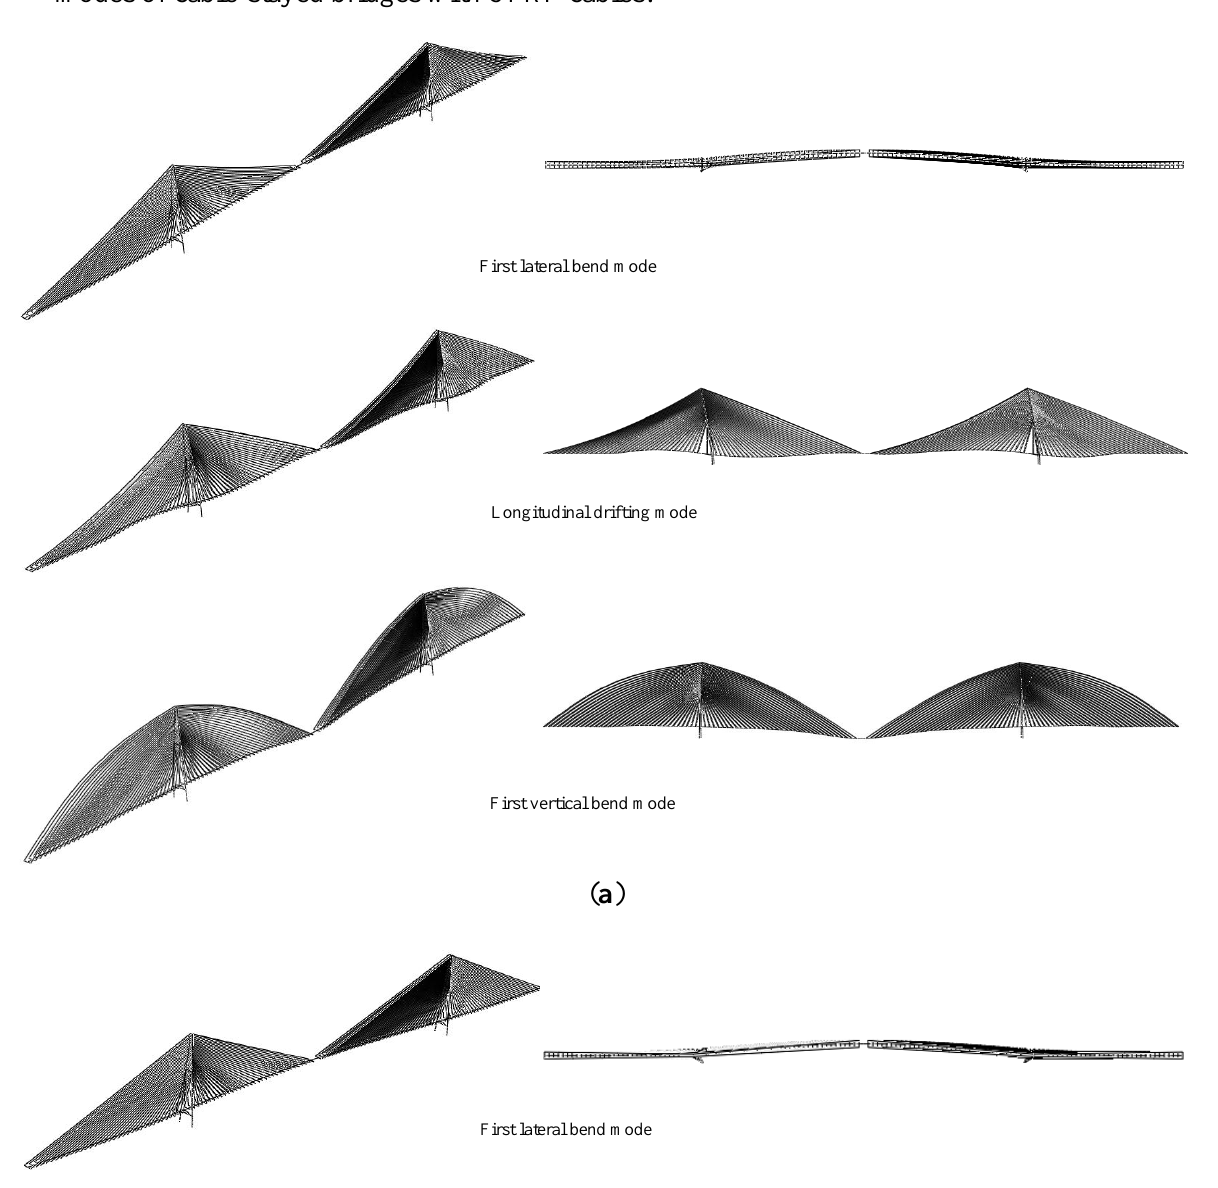
Figure 7. ( a ) Vibration modes of cable-stayed bridges with steel cables; ( b ) vibration modes of cable-stayed bridges with CFRP